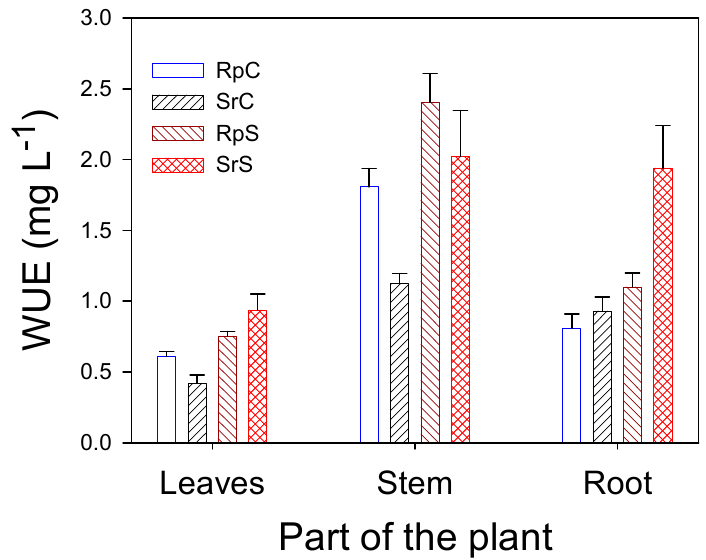
Figure 7. Water use efficiency of production (WUE) at the end of experimental period in P. dulcis plants. Means within a part of the plant without a common letter are significantly different by the Duncan 0.05 test.